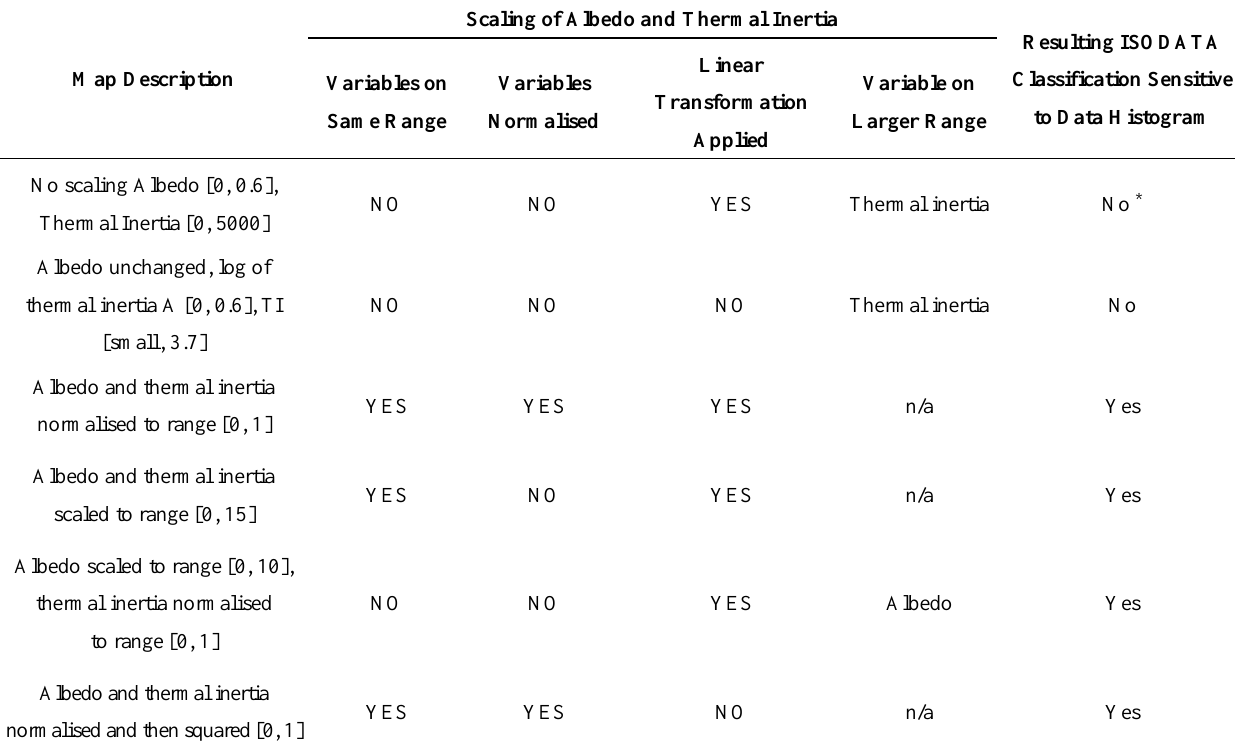
Table 4. Testing the robustness of ISODATA to scaling of input